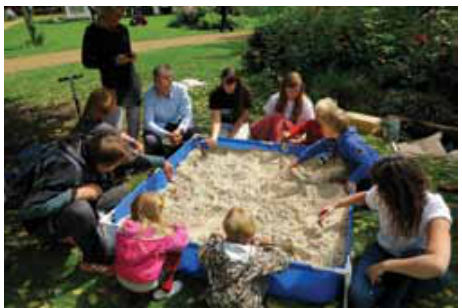
Fig. 4: A day of public outreach and engage- ment in Gordon Square. Photo: Char- lotte Frearson.